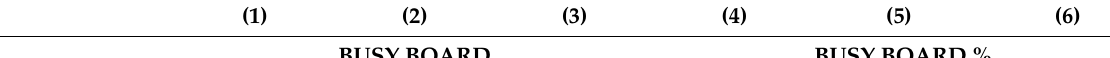
Panel D: Firm Fixed Effects (Post-Crisis Observations)